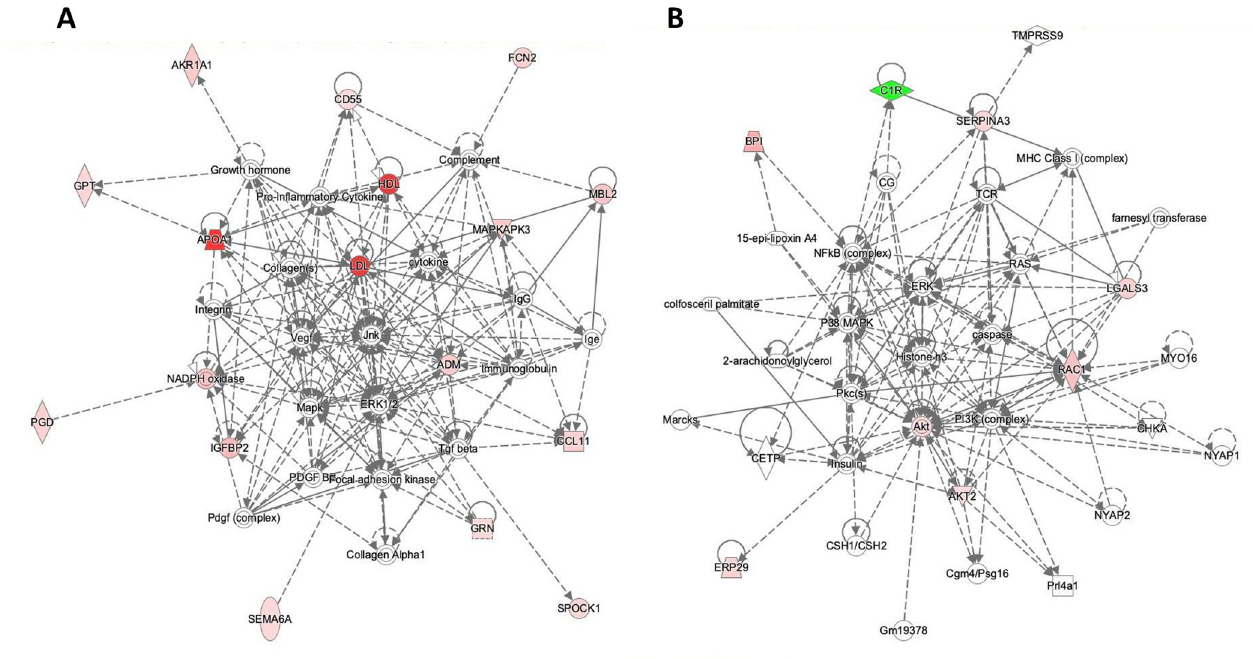
Fig 2. Biofunction analysis of exosome proteins from serum samples from patients with Raynaud’s Phenomenon with positive ANA compared to patients with Raynaud’s Phenomenon with negative ANA. A: Functional category. B-D: Biological Interactions: Inflammatory process (B); Immune response (C); and Endothelial cell and vascular involvement (D). IPA color and symbol guide: Blue = inhibition; orange = activation; red = increased; green = decreased; yellow = contrary to published evidence; grey = unknown; dashed line = indirect; arrowhead (pointed) = activating; arrowhead (blunt) = inhibitory. Proteins are coded by shape; square: Cytokine, vertical rhombus: Enzyme, horizontal rhombus: Peptidase, trapezoid: Transporter, ellipse: Transmembrane receptor, circle: Other.